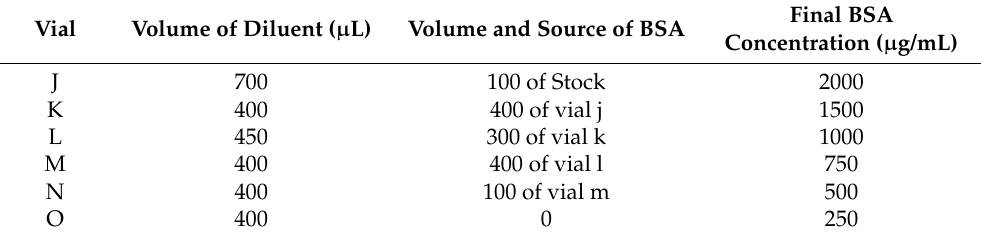
Table 2. Dilution scheme for enhanced test tube protocol with a working range of 5–250 µ